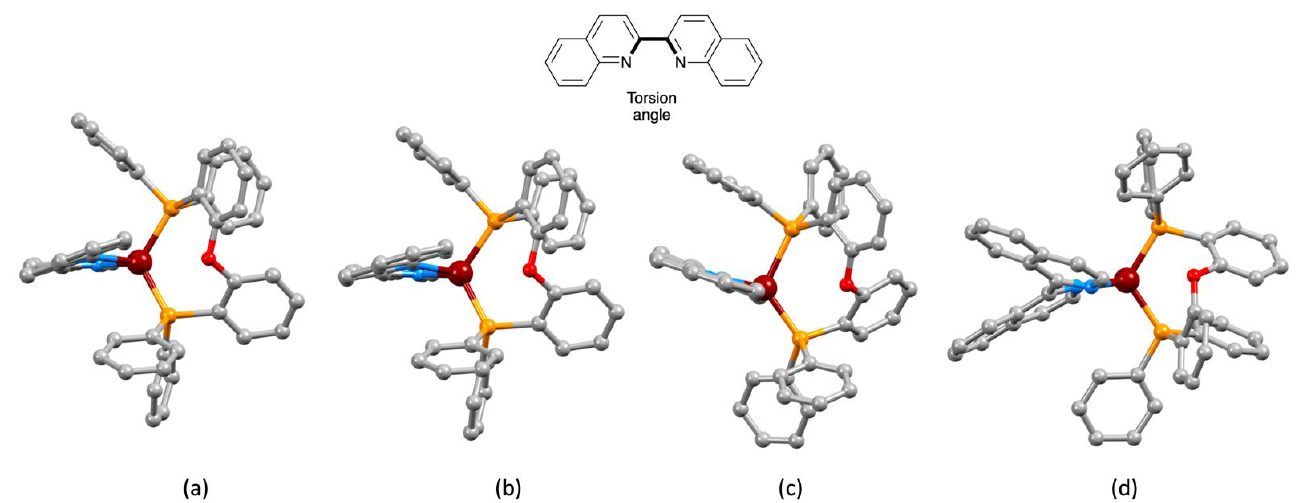
Figure 2. Crystallographically determined structures of the [Cu(POP)(bq)] + cation in ( a ) [Cu(POP)(bq)][PF 6 ] . 0.5H 2 O . 0.5CH 2 Cl 2 , ( b ) [Cu(POP)(bq)][PF 6 ] . CF 3 SO 3 . 0.6H 2 O, and ( c ) [Cu(POP)(bq)][BF 4 ] . 2MeOH. The figures were generated using coordinates from the Cambridge Structural Database (CSD) refcodes CAPLIR, XIQTEZ, and JITNIK, respectively. ( d ) The structure of the [Cu(POP)(biq)] + cation (this work) for comparison. The N–C–C–N torsion angle in Table 1 is defined in the diagram at the top.